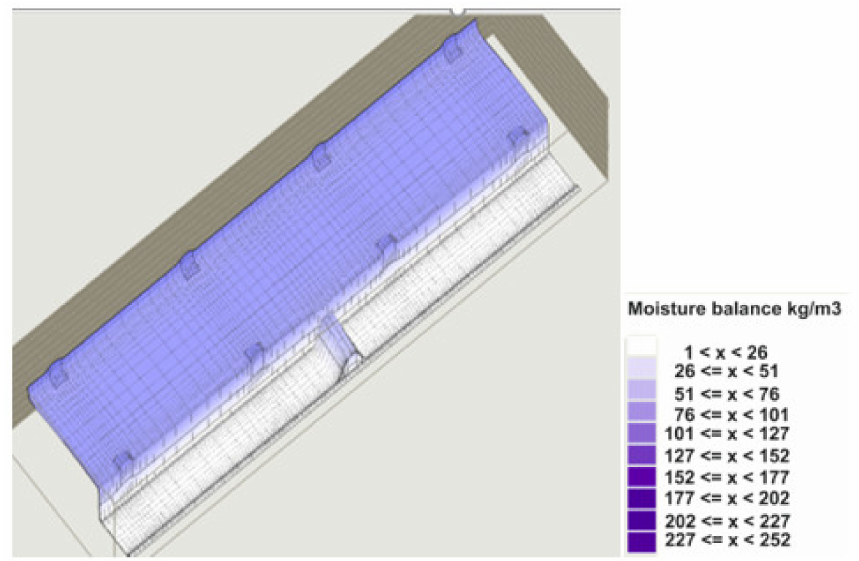
Figure 28. Wall insulated with mineral wool—completion time (3 years).